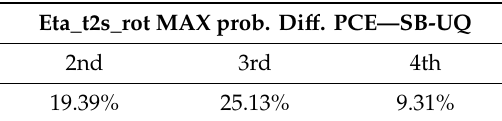
Table 7. Rotor efficiency maximum absolute probability differences from SB-UQ approach.